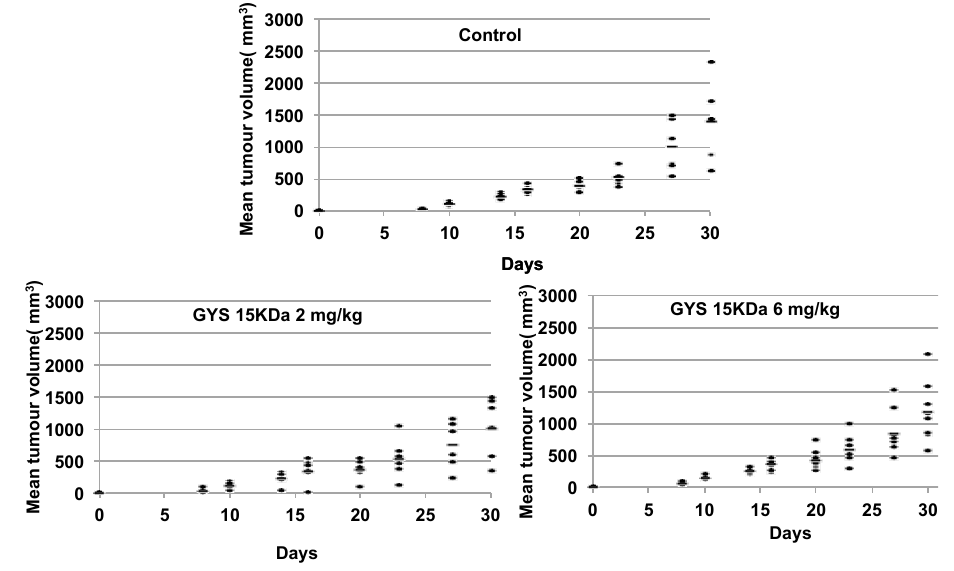
Figure 6. Effect of OS-EPS 15 kDa derivative on the in vivo HOS osteosarcoma tumor growth: 2 × 10 6 HOS cells were inoculated in paratibial area. When tumor volume reached 100 mm 3 , OS-EPS 15 kDa (2 or 6 mg/kg daily) was injected subcutaneously each day and the tumor growth was measured from Day 5 to Day 30.